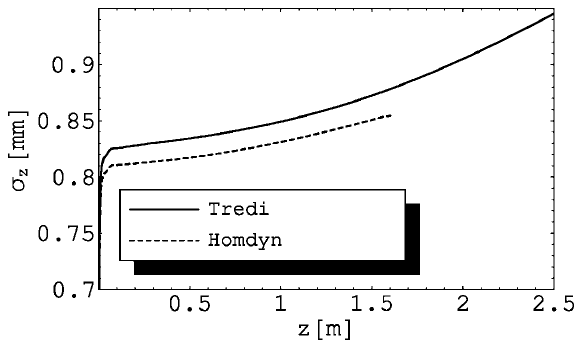
FIG. 9. The rms bunch length.